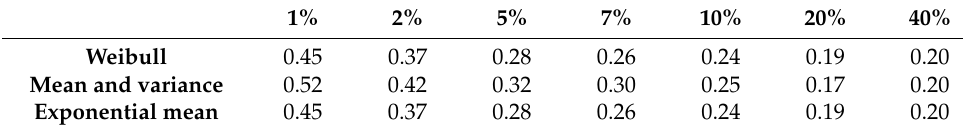
Table 11. Main statistics of the charge vector Weibull and Exponential cdf.